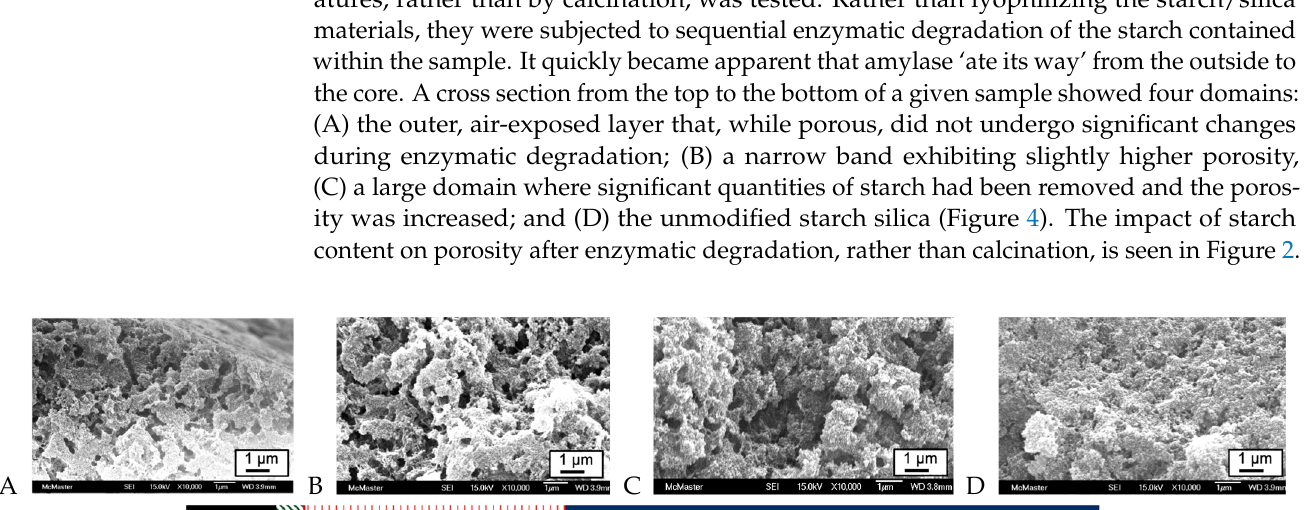
Figure 3. As-prepared ( A ) upper gel surface from recipe 6 (Table 1) (scale bar 10 microns); ( B ) higher magnification of A (scale bar 1 micron); ( C ) the same sample calcined at 600 °C 1200–1400 m 2 g − 1 (see also Figure S1).